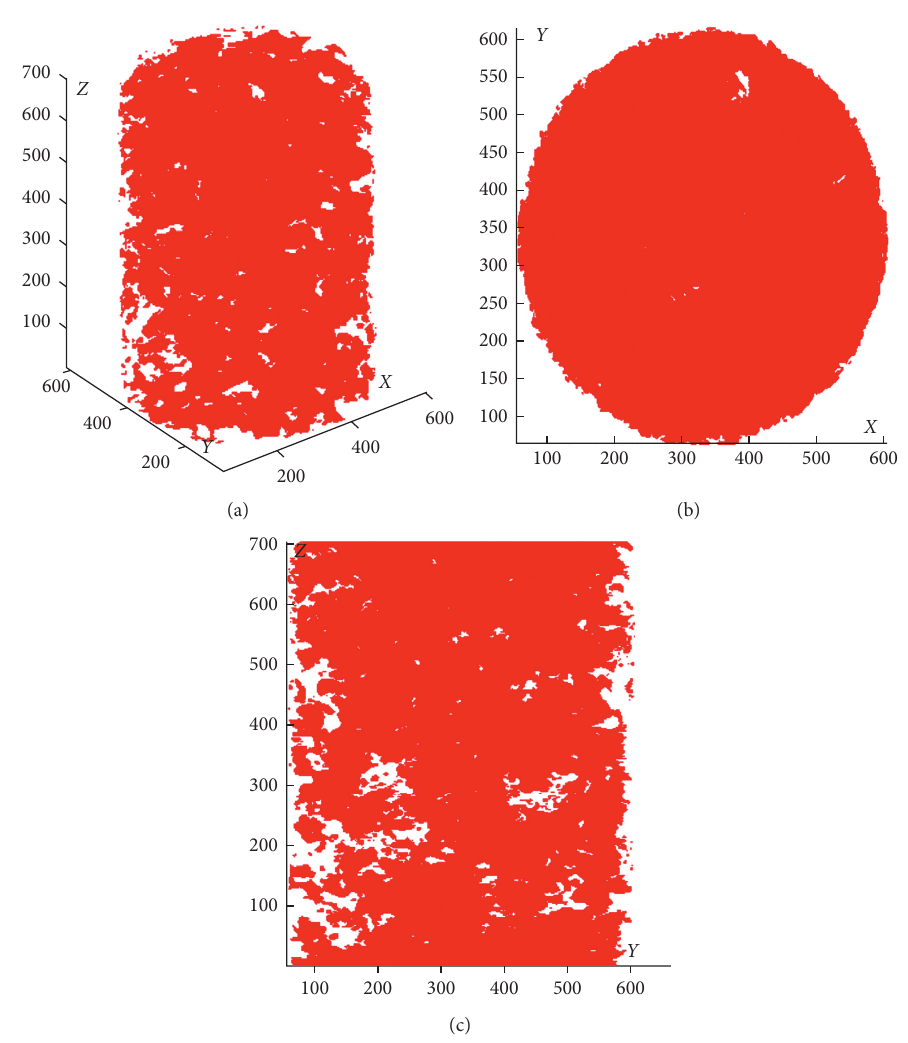
Figure 14: Air void distribution of PA13 specimen. (a) Three dimensions. (b) Projection in transverse section. (c) Projection in vertical